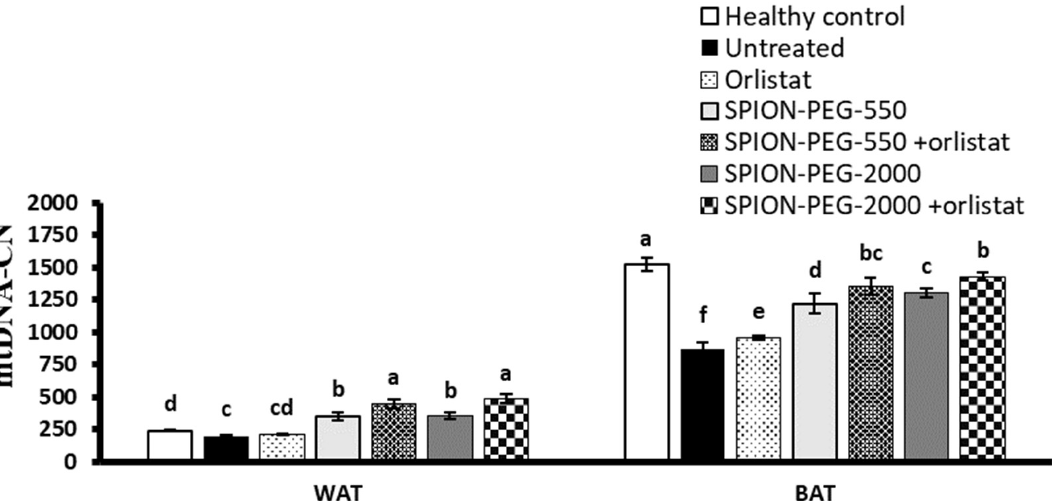
Figure 10. Mitochondrial DNA copy number (mtDNA-CN) in white and brown adipose tissues in control rats and obese rats untreated or treated with SPIONs and/or orlistat. Data presented as mean ± SD, and n = 8. Groups were compared at p < 0.05 using one-way ANOVA and Tukey post hoc test, and those which are not assigned with a shared letter (a–f) are statistically significant.